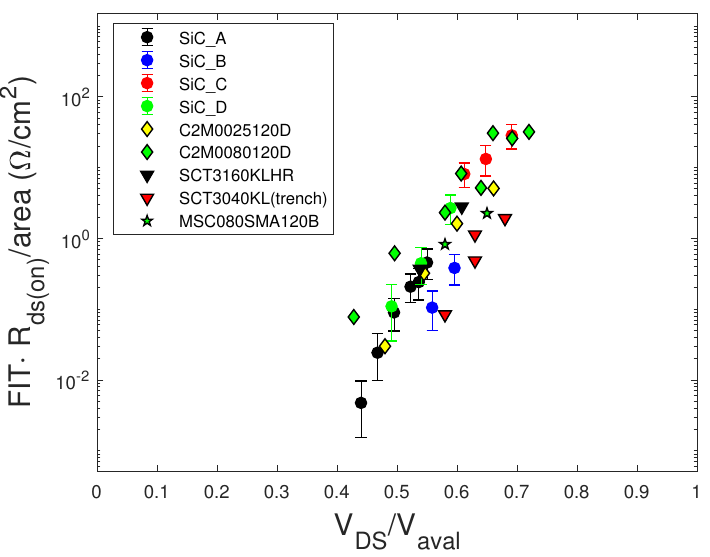
Figure 9. FIT · R ds ( on ) /cm 2 data versus V DS / V aval of the samples of Figure 8. The FIT/cm 2 versus V DS / V aval data (not shown) of the investigated Si MOSFETs and IGBTs did not follow a common trend, although general models for cosmic ray-induced failures in silicon power devices exist